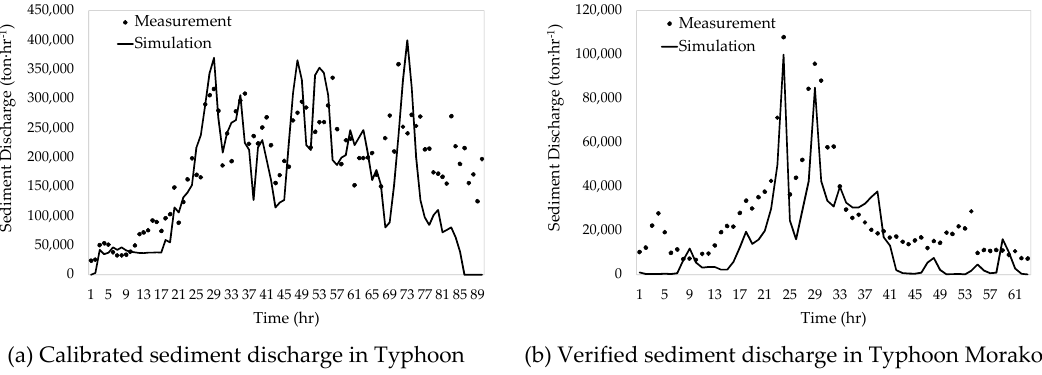
Figure 3. Calibration and verification results for the sediment discharge.